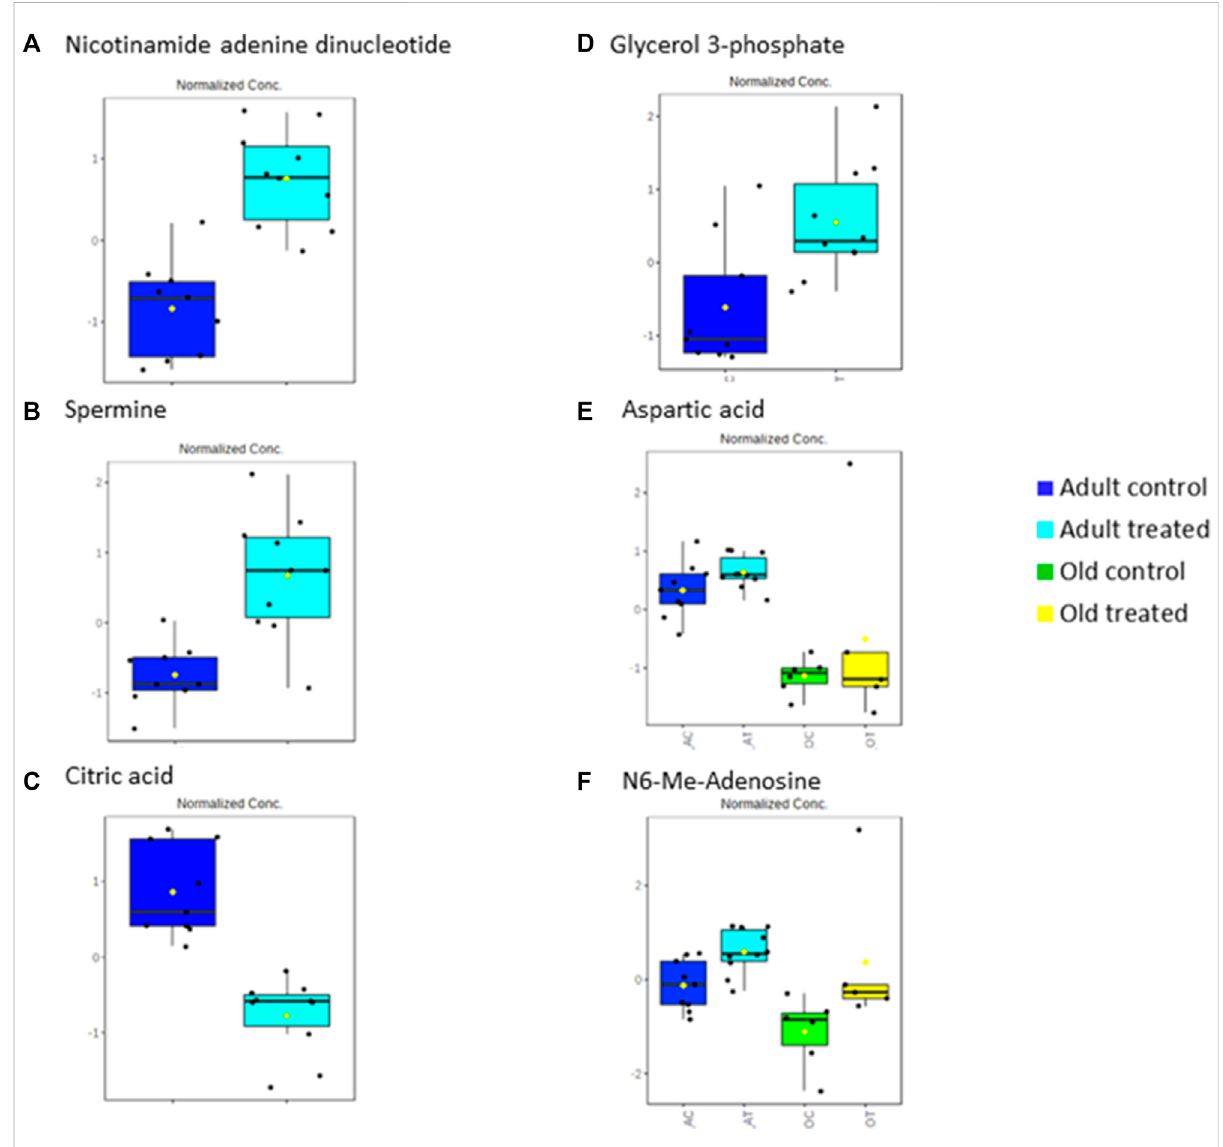
FIGURE 9 Signi fi cant metabolic changes after tocotrienol-rich fraction